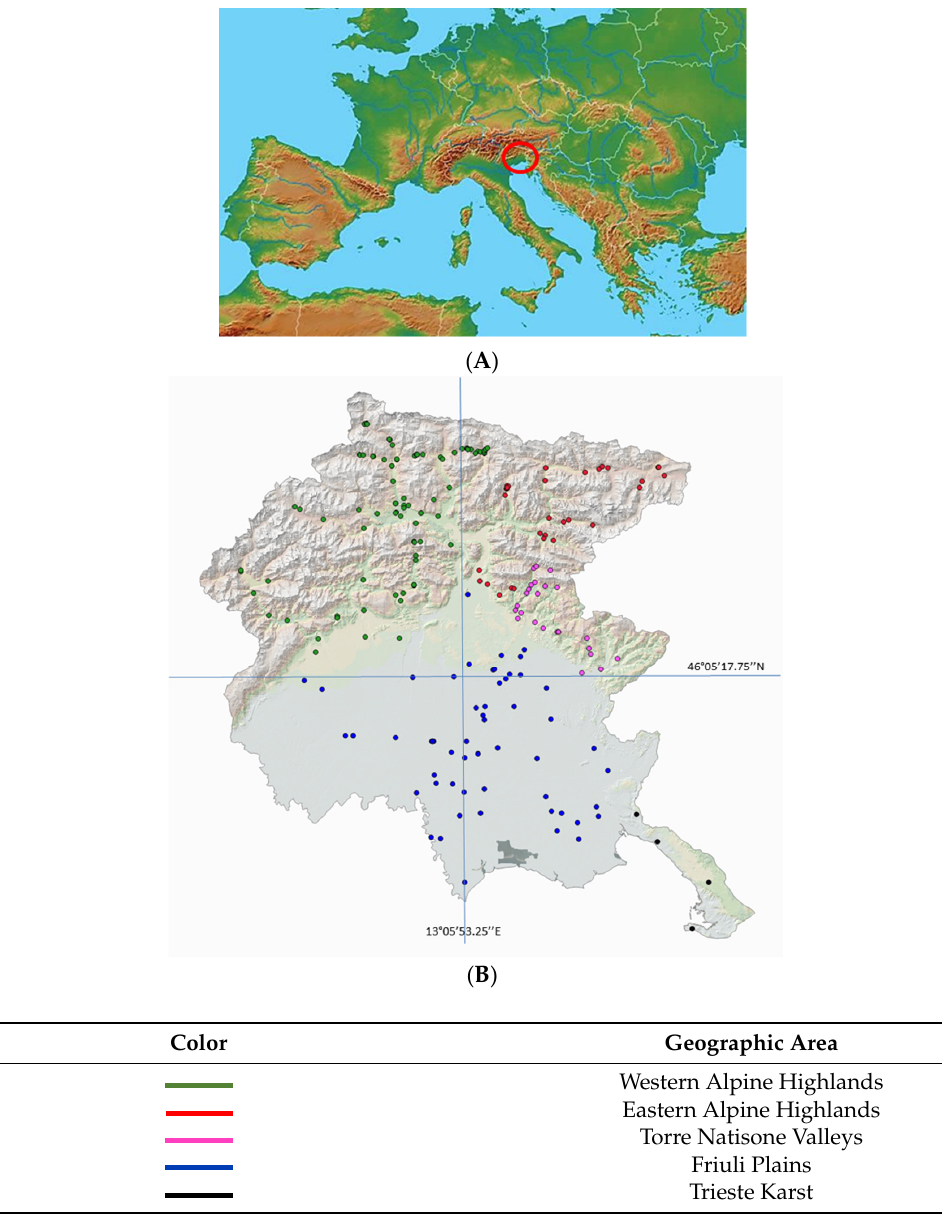
Figure 1. ( A ) General map with a red circle representing the region of study; ( B ) Explosion of the sampling areas, for the color code see the legend below.